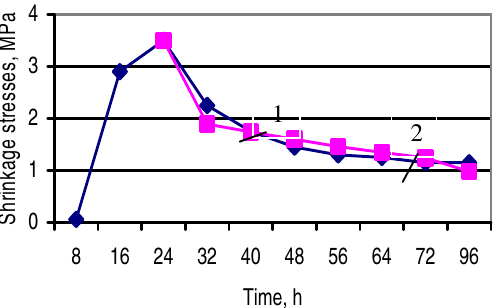
Fig 5 . Comparison between experimental shrinkage stresses (1) and the computed values (2) based on Eq (21) of polymer mastic (1:2,25)